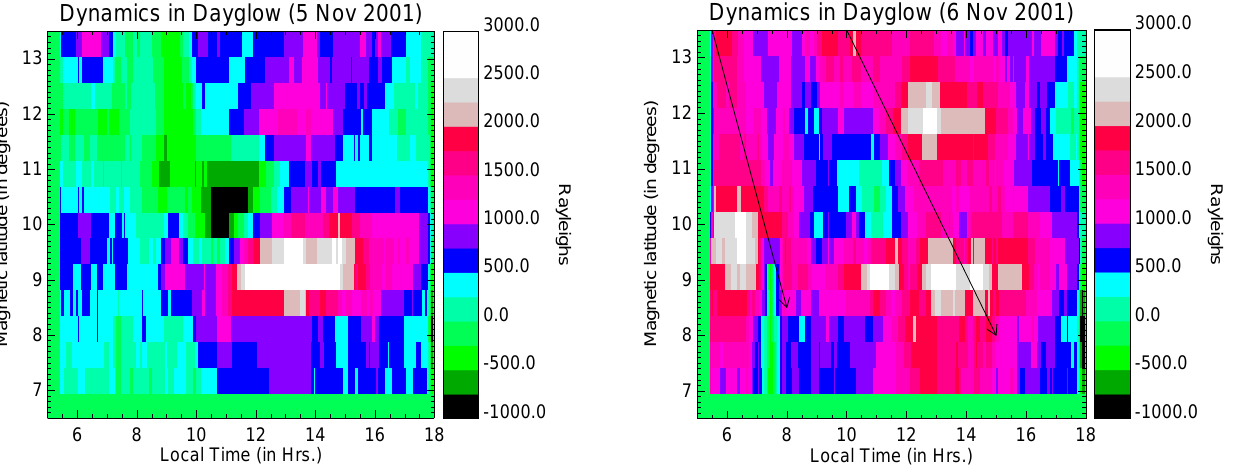
Fig. 7. Same as in Fig. 6 but for 6 November 2001. Notice the sharp rise in the emissions during the morning hours (05:30–08:30 LT), which are 4–5 times larger than the emissions of dynamical com- ponent on quiet days, as can be seen in Figs. 5, 6 and 8. The time duration of morning rise is larger in 9 ◦ –13.5 ◦ magnetic latitudes compared with the duration of increase in 7 ◦ –9 ◦ magnetic latitudes. Emission enhancements are also seen around 12 ◦ and 9 ◦ magnetic latitudes at 12:30 LT and 13:30 LT, respectively, most likely indi- cating propagation of neutral species from high to low latitudes. The arrow indicates a possible direction of the phase propagation of the neutral species from high to low latitudes. The contribution of the dynamical component is largest on this day compared with the quiet days shown in Figs. 6 and 8, possibly due to the presence of comparatively larger neutral densities that are redistributed by the magnetic storm